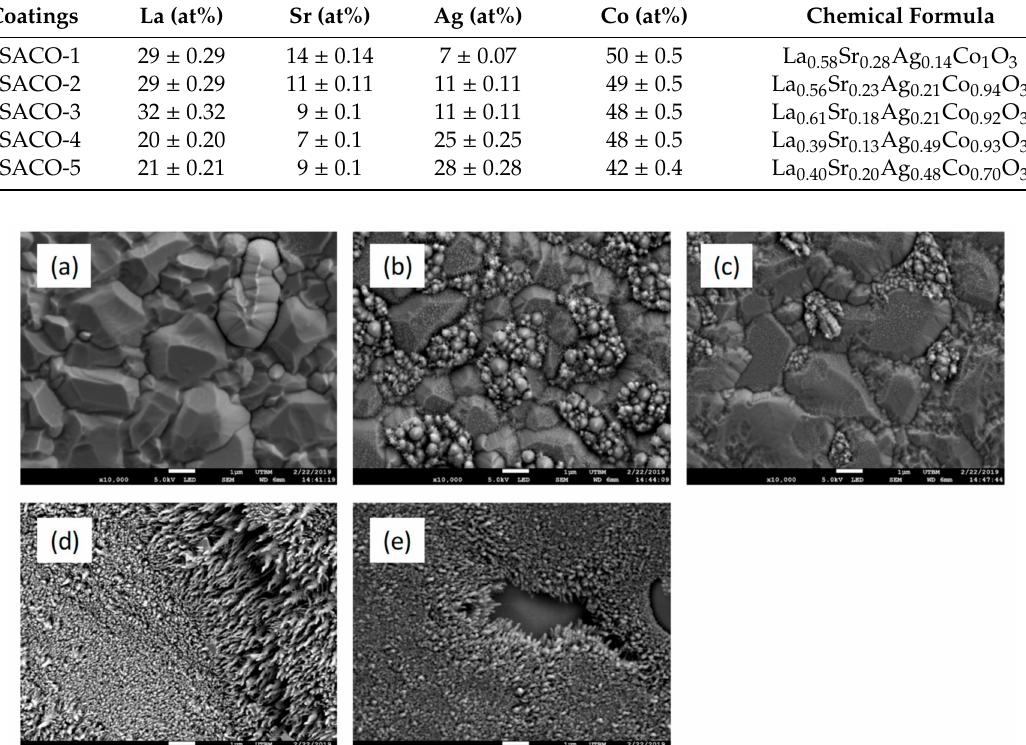
Figure 5. SEM images of the surface morphology of as-deposited LSACO coatings on alumina substrate: ( a ) LSACO-1, ( b ) LSACO-2, ( c ) LSACO-3, ( d ) LSACO-4, and ( e )